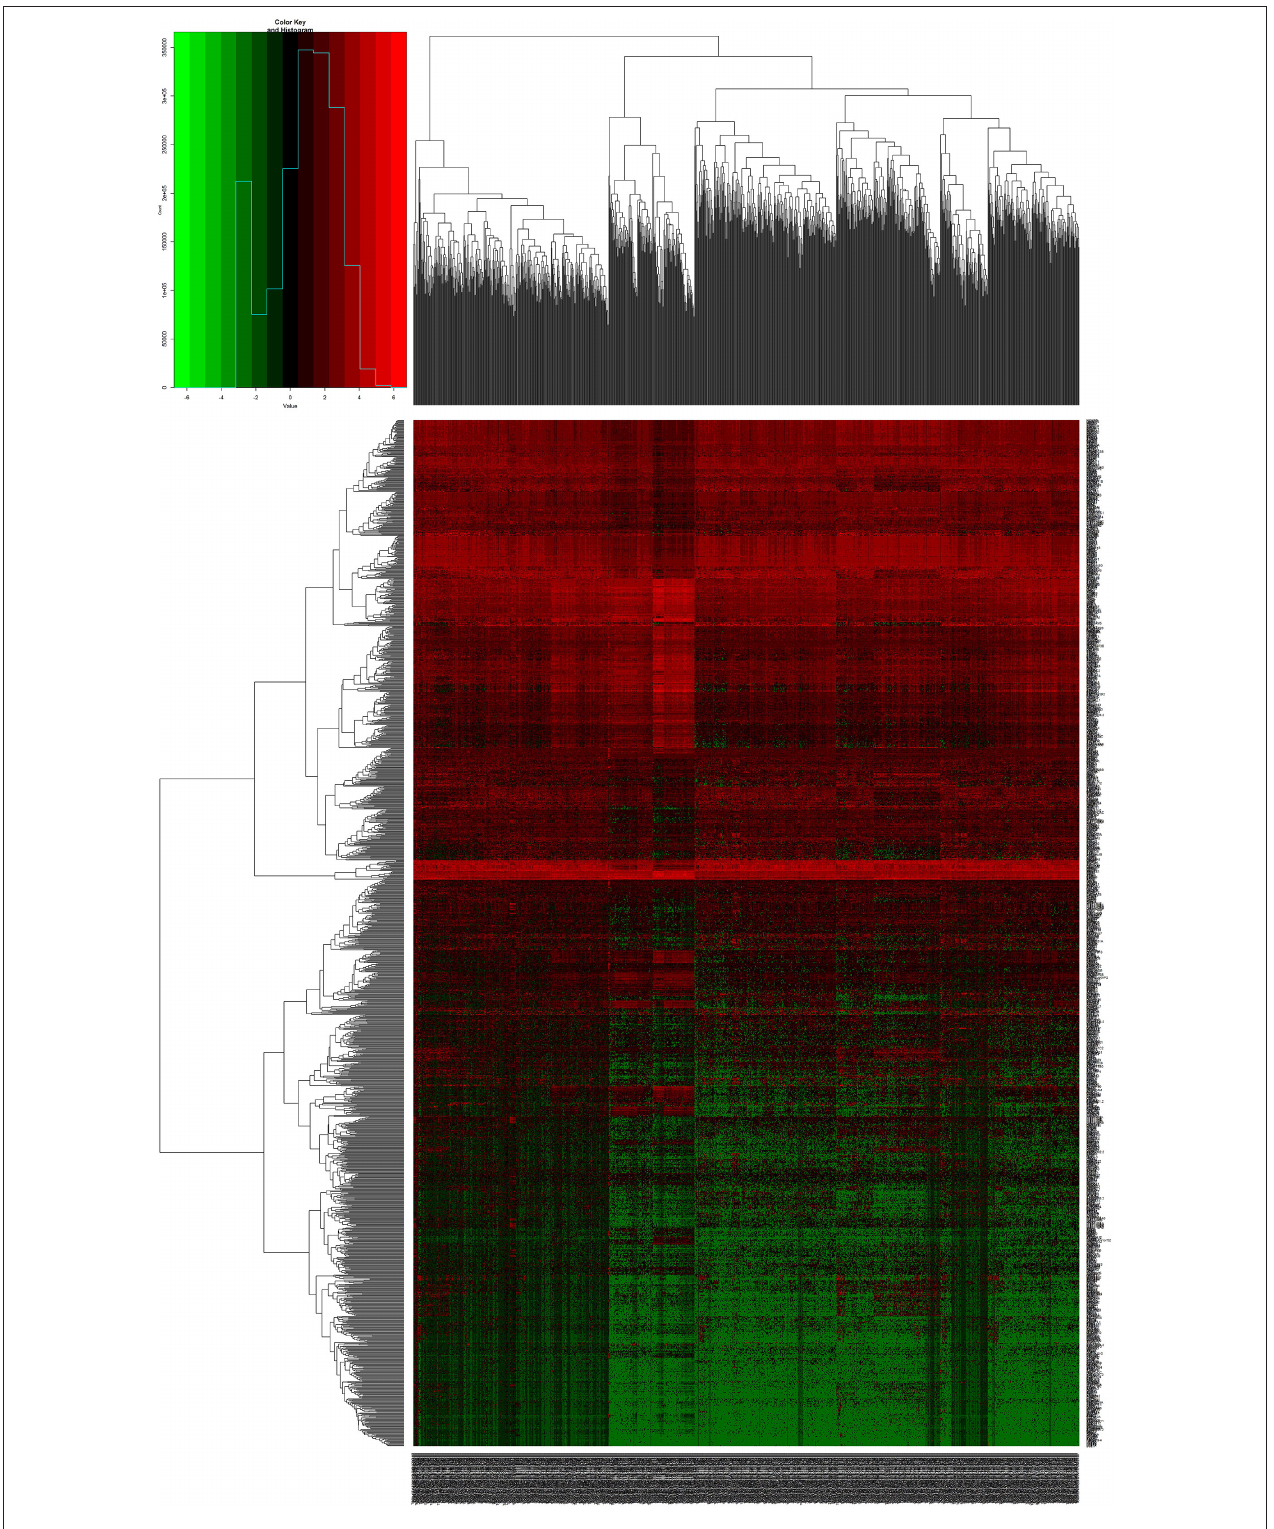
FIGURE 1 | Heat maps of breast cancer-related differentially expressed DEGs. The color from green to red shows a trend from low expression to high expression.